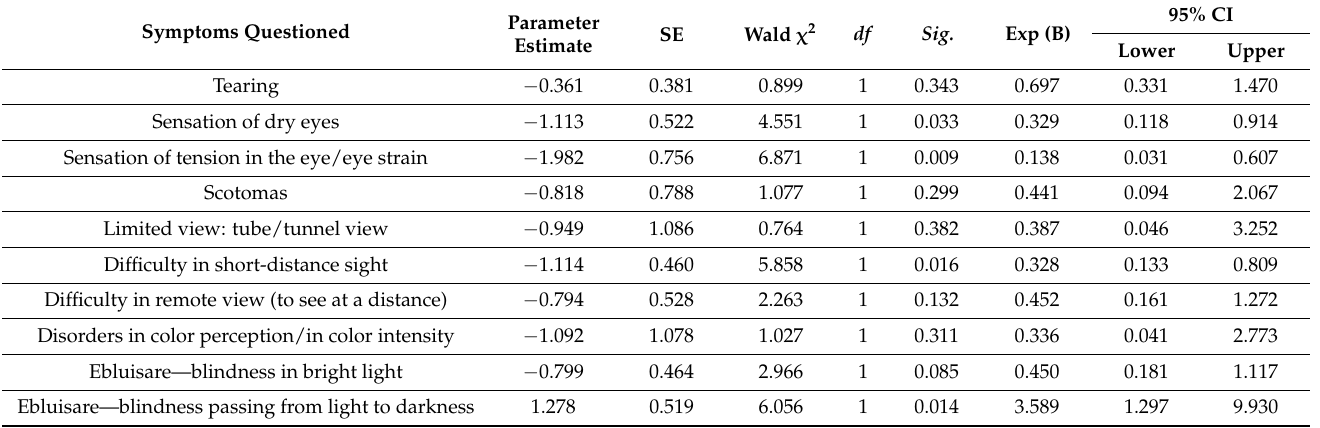
Table 14. Distribution of binomial logistic regression parameters to the symptom questionnaire in NTG and NG patients.